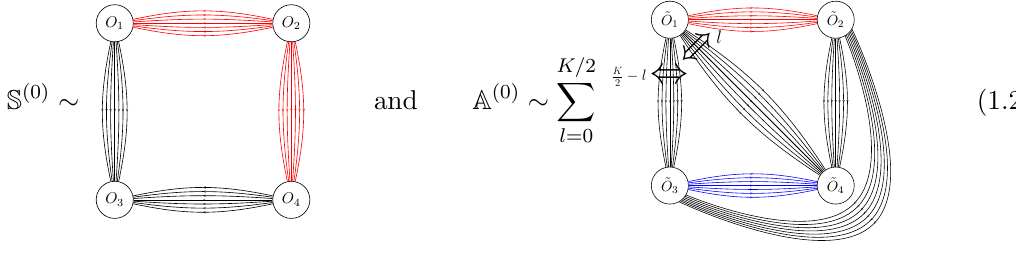
. Each state ij picks H wraps around operators H H H ! 23 ! 34 ! 14 ! 12 O 1